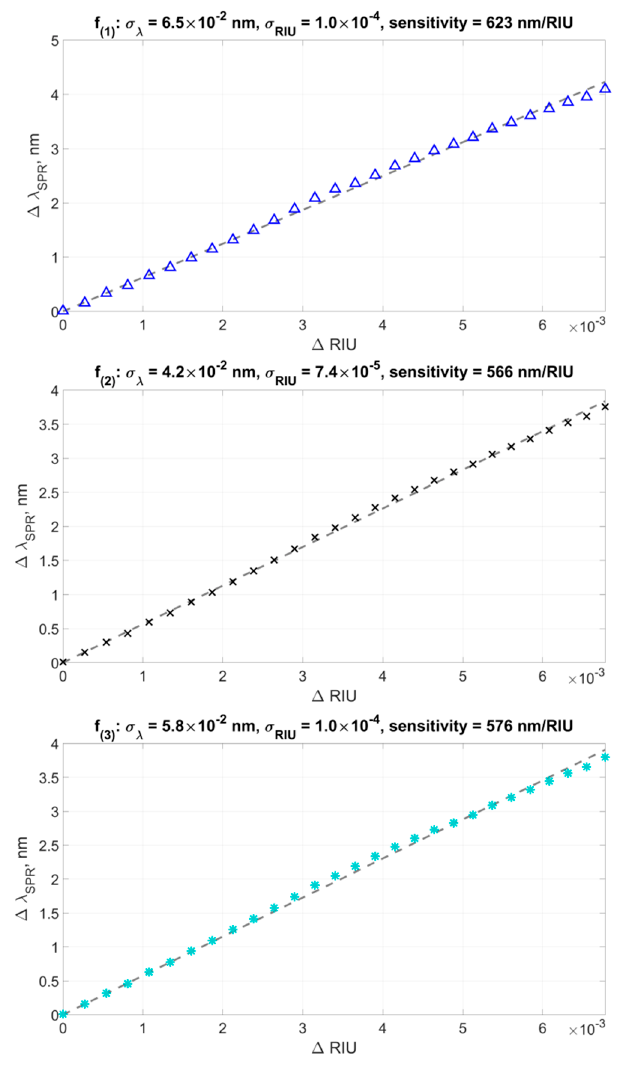
Figure 14. Dependence of the SPR wavelength shift calculated from the data of the first experiment according to methods f ( 1 ) (a), f ( 2 ) (b), f ( 3 ) (c) on the change in the refractive